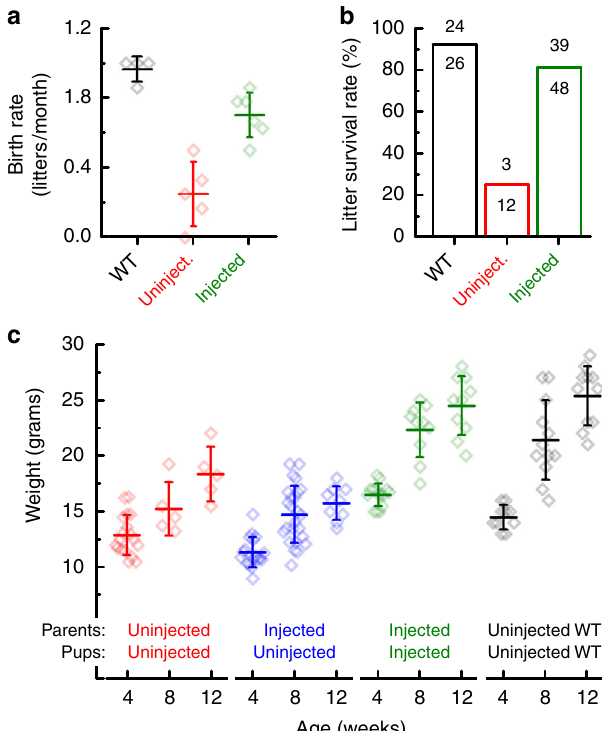
Fig. 6 sAAV- Tmc1 improves breeding, survival and growth in Tmc1 Δ / Δ ; Tmc2 Δ / Δ mice. a Mean ± S.D. birth rate for litters produced by four wild- type C57BL/6 breeding pairs (black), fi ve uninjected Tmc1 Δ / Δ ;Tmc2 Δ / Δ breeding pairs (red) and six Tmc1 Δ / Δ ;Tmc2 Δ / Δ breeding pairs injected with sAAV- Tmc1 (green). Birth rate was calculated for each breeding pair based on number of litters divided by duration mated. b Litter survival rates wild- type (black), uninjected Tmc1 Δ / Δ ;Tmc2 Δ / Δ mice (red), and Tmc1 Δ / Δ ;Tmc2 Δ / Δ parents injected with sAAV- Tmc1 (green). Number of litters that survived to wean age (P21) over number produced at P0 are shown above each